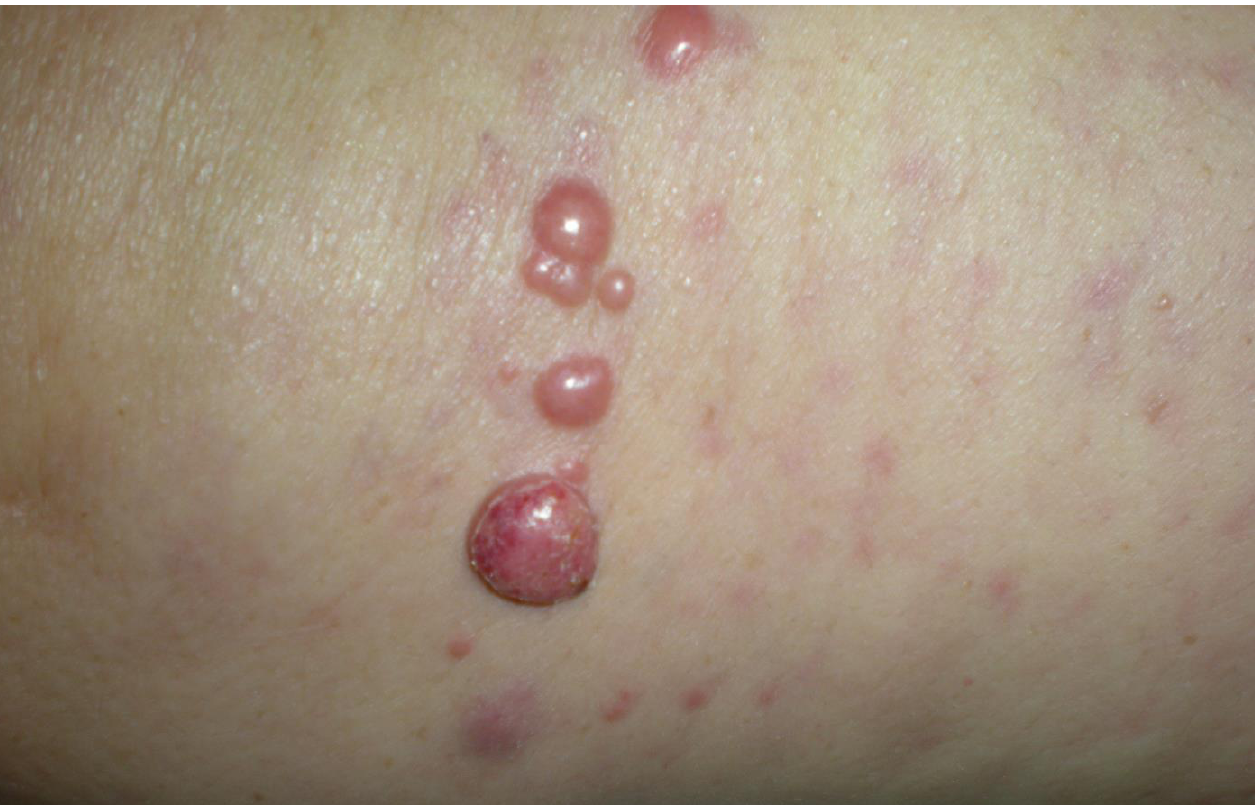
Figure 1. Locoregional metastases in a patient with MCC.